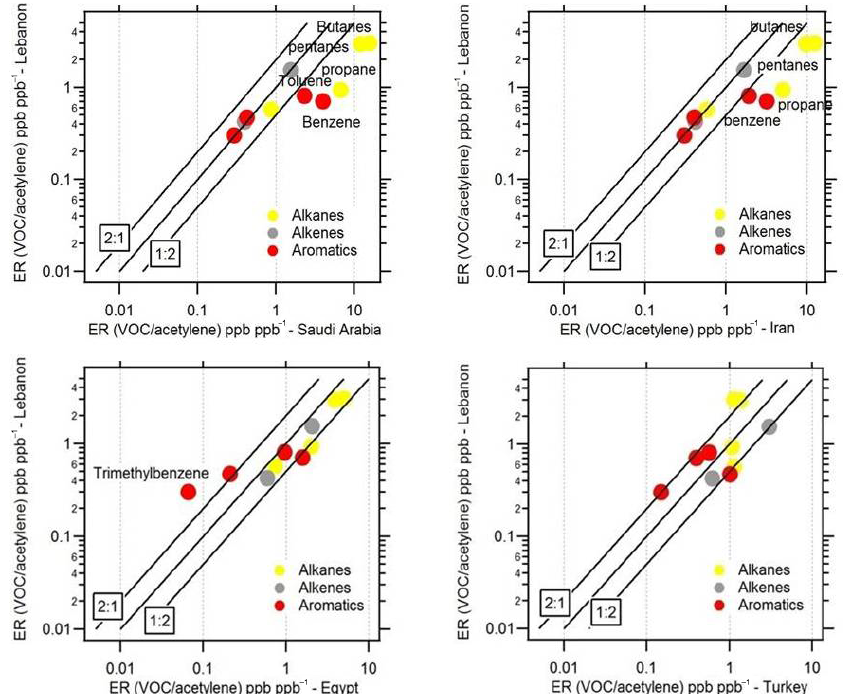
Figure 12. Comparison of the emission ratios from ACCMIP relative to acetylene for all the anthropogenic sectors for five Middle Eastern countries (Lebanon, Egypt, Turkey, Iran, and Saudi